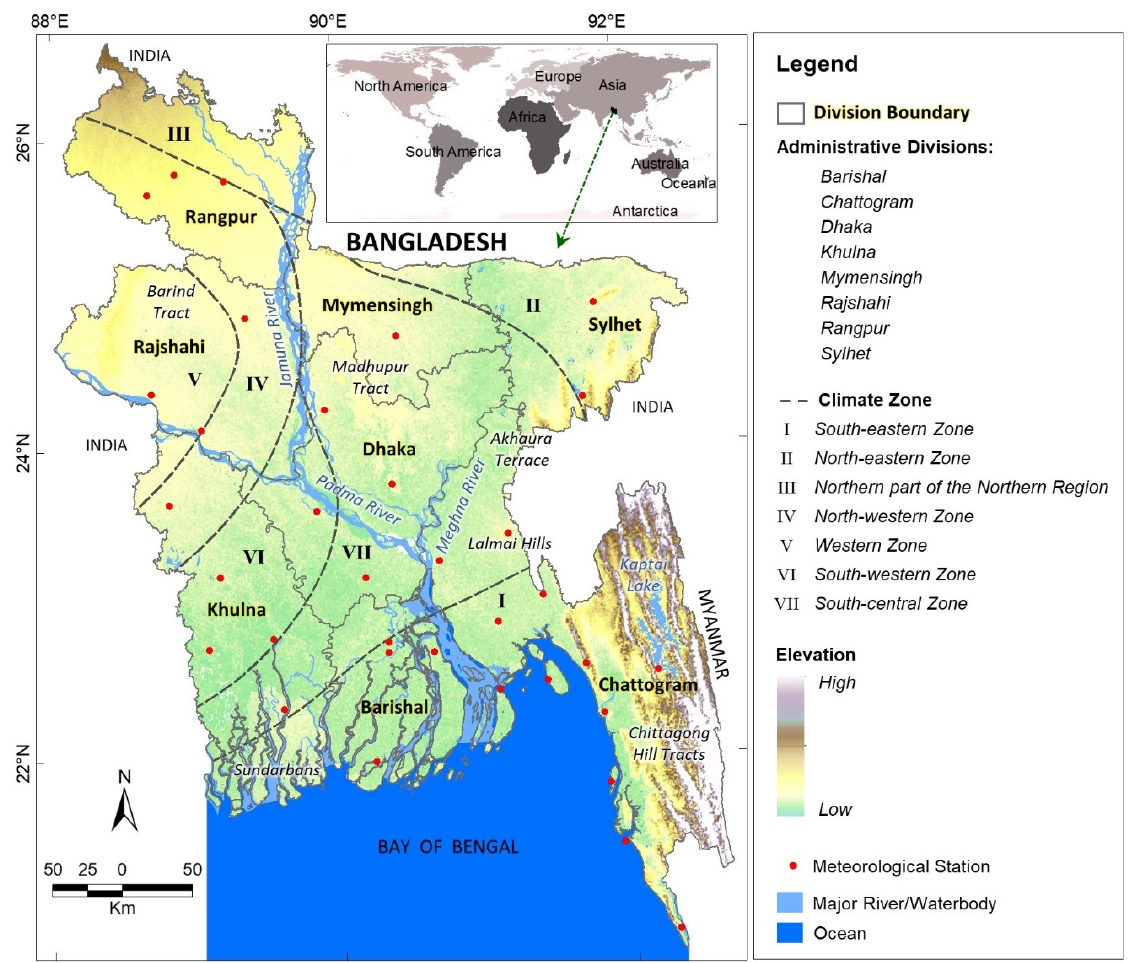
Figure 1. Study area showing the eight administrative divisions and climatic sub-zones of Bangla- desh.